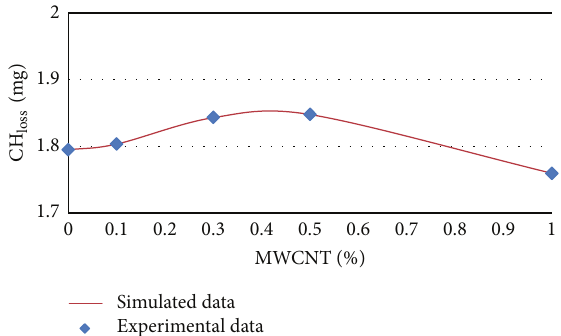
Figure 12: Experimental and simulated values of CH loss for 56 days by artificial neural